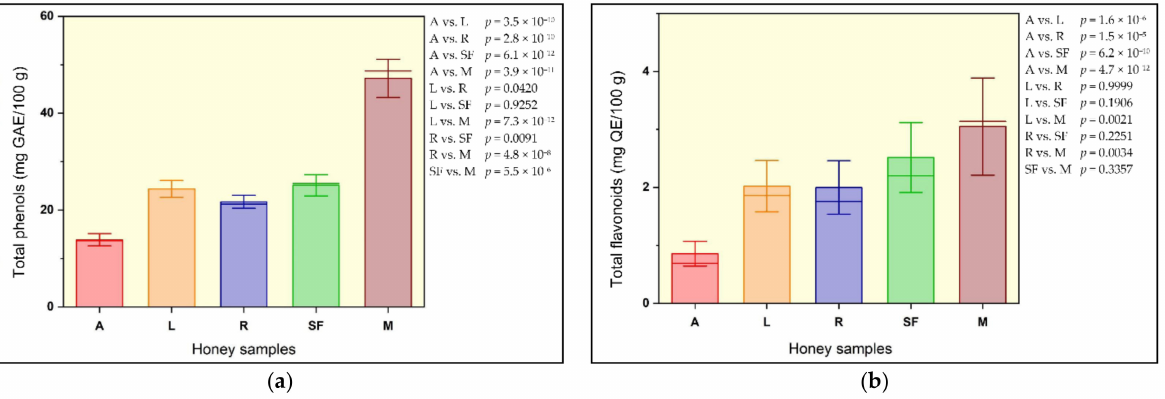
Figure 3. Mean content, standard error and mean line values of some honey sample parameters: ( a ) total phenols; ( b ) total